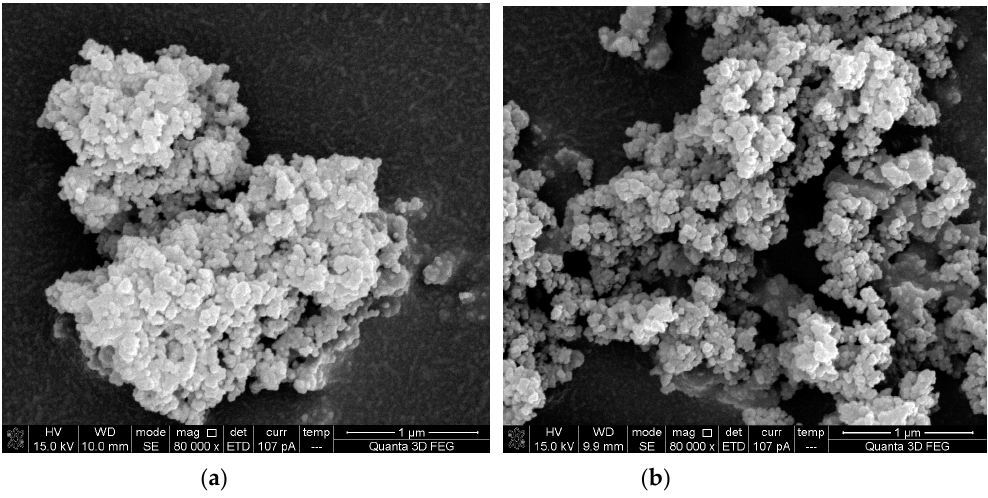
Figure 7. SEM micrographs of NS and MNS. ( a ) NS; ( b ) MNS.